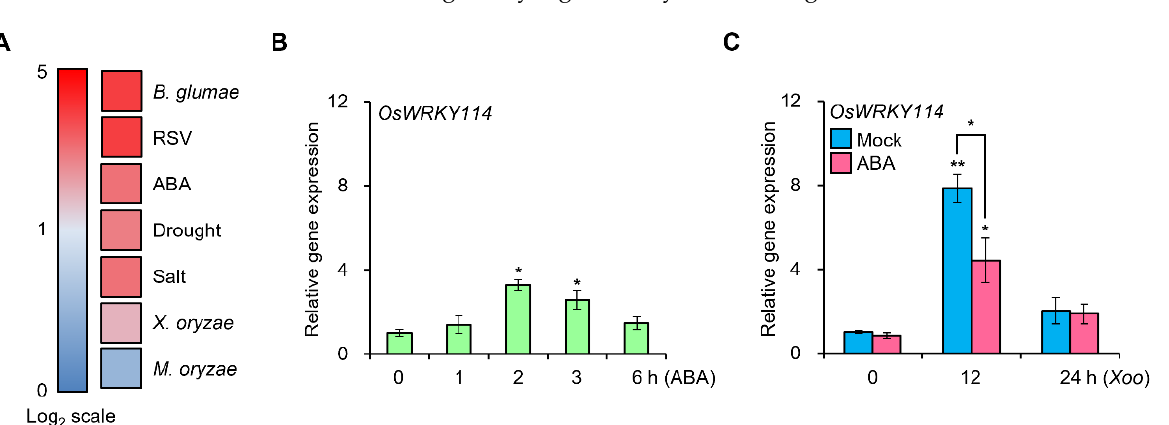
Figure 1. ABA modulates the transcription of OsWRKY114 during Xoo inoculation. ( A ) Expression profile of OsWRKY114 under various stress conditions. Gene expression data were obtained from Genevestigator. ( B ) Relative OsWRKY114 transcript level after ABA treatment, as determined by RT-qPCR. Four-week-old rice plants were sprayed with 100 µM ABA and incubated for the indi- cated times. cDNA was synthesized from total RNA in rice leaves. OsActin was used as an internal control. Data are shown as means ± standard deviation (SD). * p < 0.05 by t -test relative to the 0 h sample. ( C ) Relative OsWRKY114 transcript level in ABA-treated plants after Xanthomonas oryzae pv. oryzae inoculation. Four-week-old rice plants were pretreated with 100 µM ABA or mock (0.2% [ v / v ] Tween 20) solution. Three days later, leaves were inoculated with Xoo and collected after the indicated incubation times. cDNA was synthesized from total RNA in rice leaves. OsActin was used as an internal control. Data are shown as means ± SD. * p < 0.05, ** p < 0.01, determined by t -test relative to the 0 h mock-treated sample and between the indicated comparing samples.